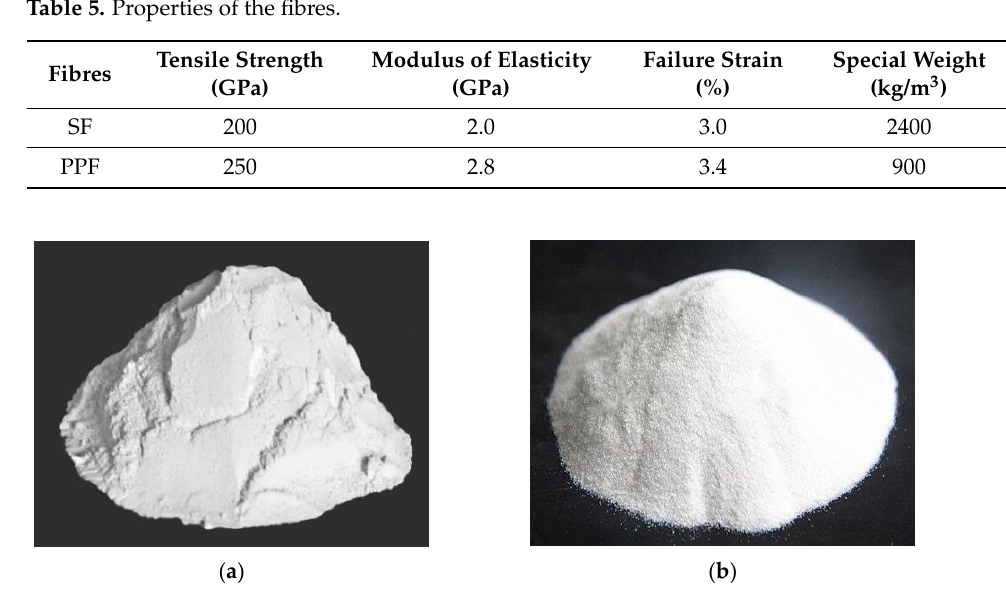
Figure 3. ( a ) SP and ( b ) NS. Table 6. Chemical components of SP and NS.